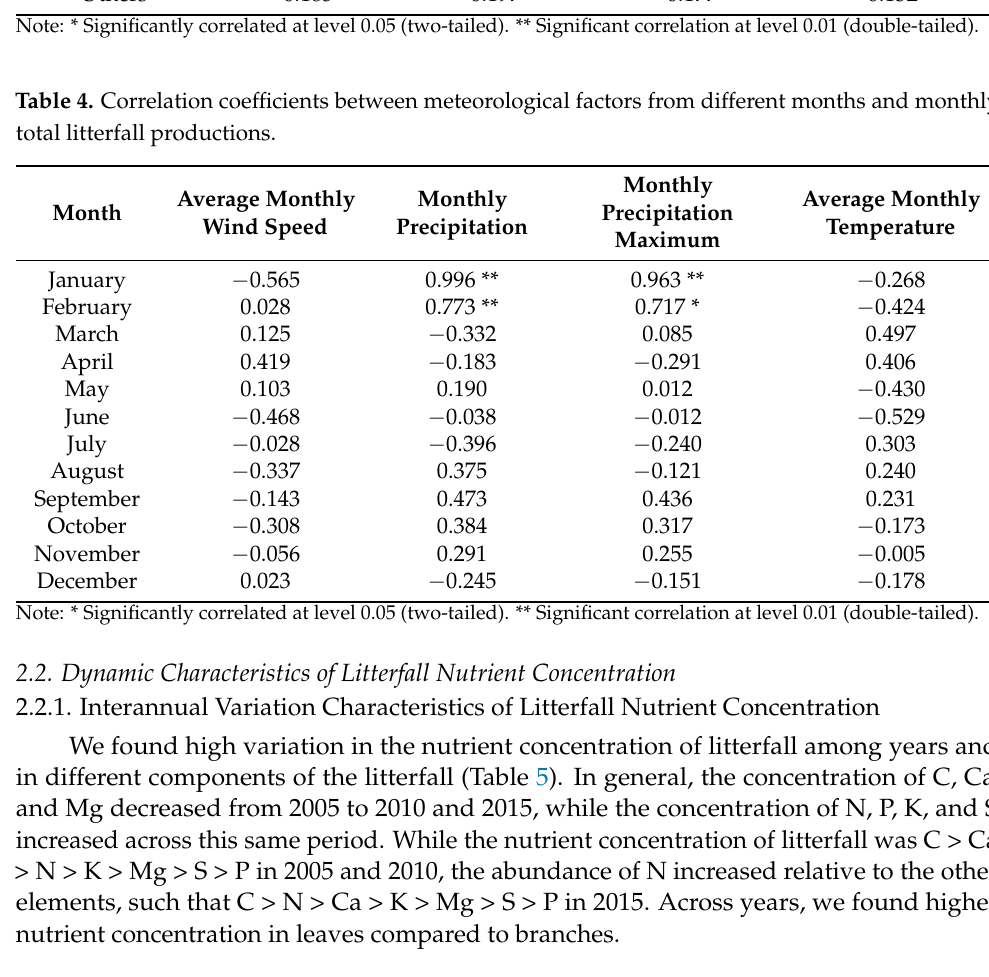
Table 5. Characteristics of annual average nutrient concentration of litterfall in different